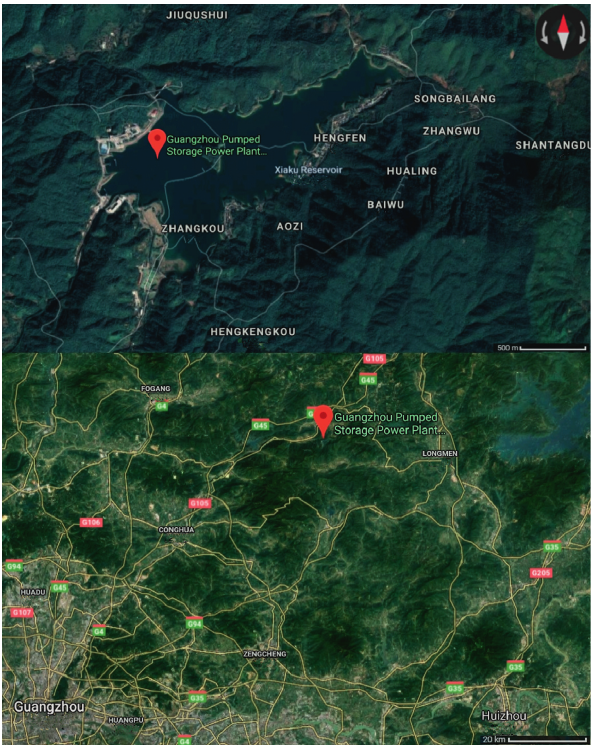
Figure 2: Geographical location map of Guangzhou pumped storage power